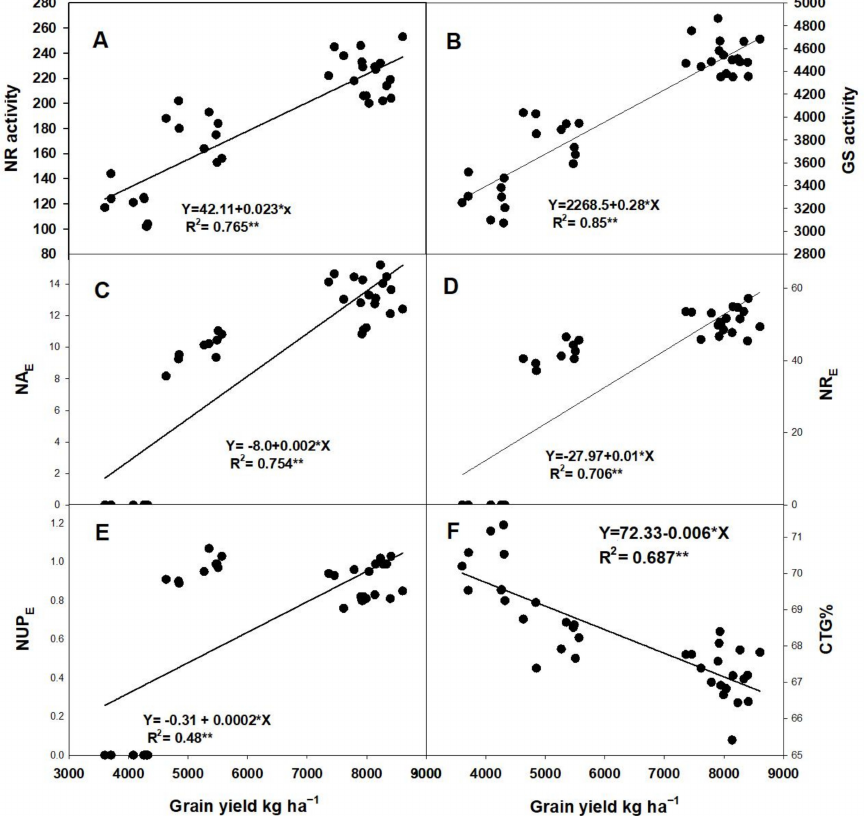
Figure 6. Regression analyses among GY and nitrate reductase (NR)/( A ) glutamine synthesis (GS)/(P B ), N agronomy efficiency (NAE)/( C ), N recovery efficiency (NR E )/( D ), N uptake efficiency (NUP E )/( E ), and contribution of N translocation to the grain after the anthesis stage (CTG)/( F ), respectively. * p ≤ 0.05 and ** p ≤ 0.001,